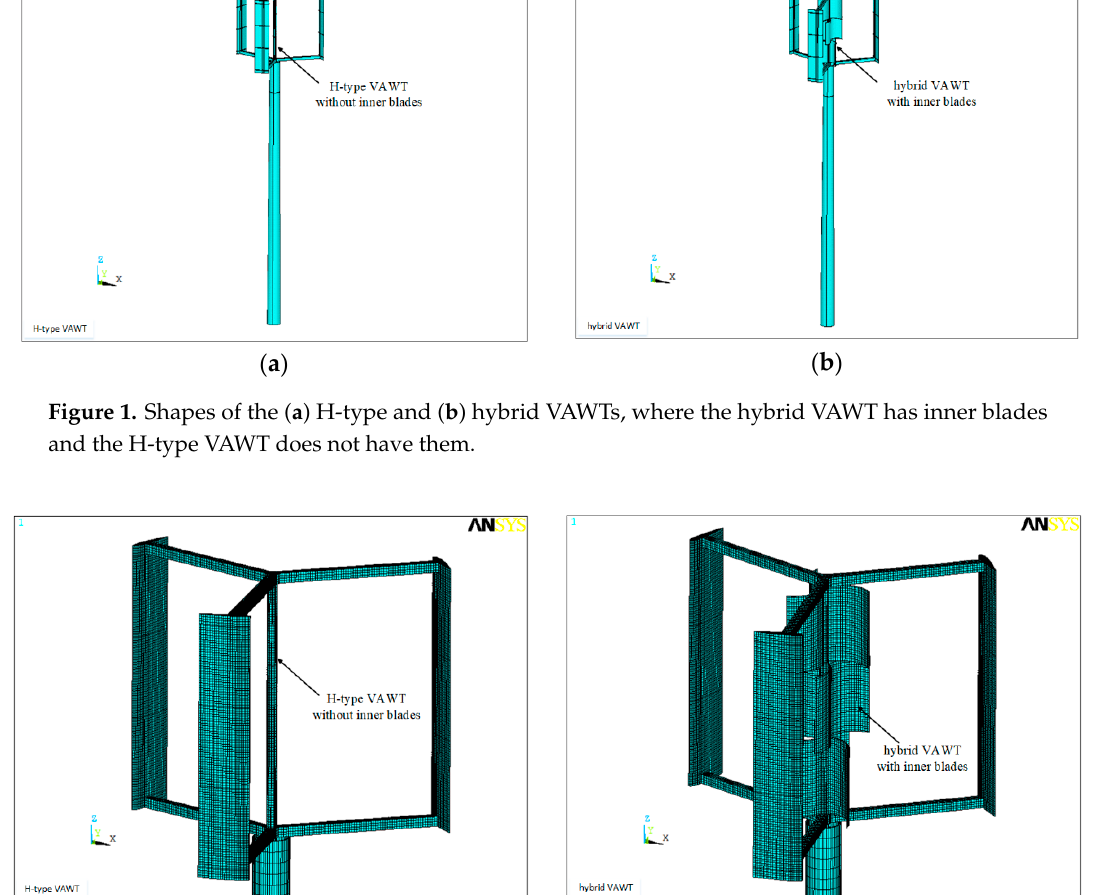
Figure 2. Details of blades of the ( a ) H ‐ type and ( b ) hybrid VAWTs.